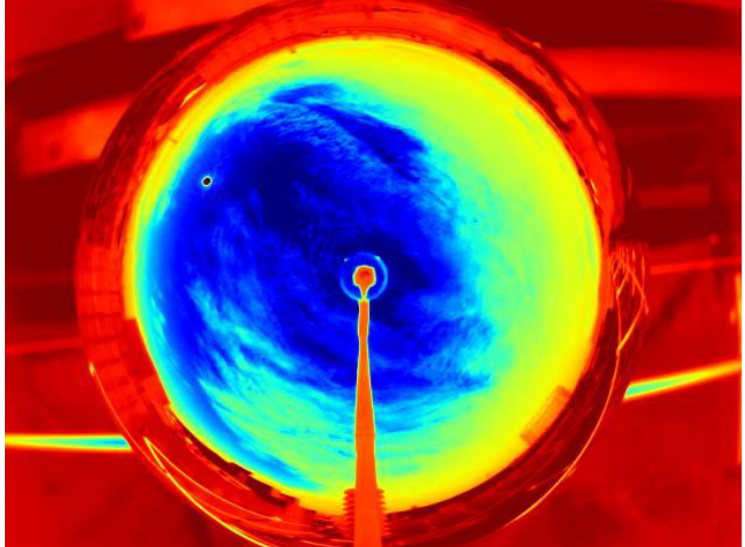
Figure 3. Image acquired on 20 September 2019 at 10.05 a.m.: the blue part is the clear sky, the clouds are represented with different shades and the red that surrounds all the image is the camera sys- tem